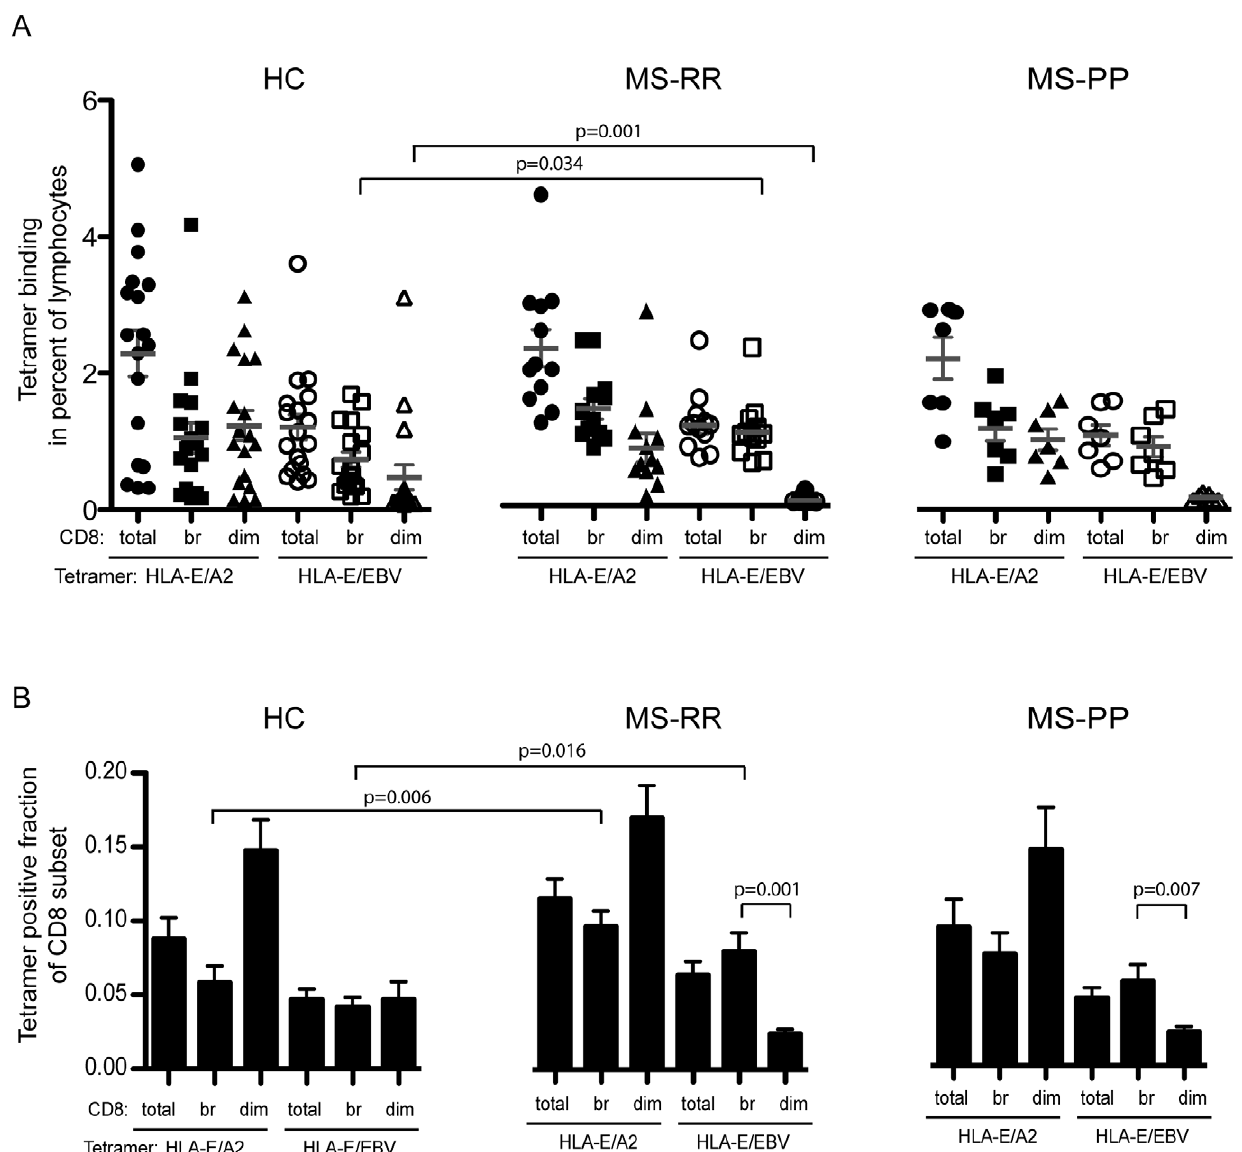
Figure 3. Increased frequency of cells recognizing HLA-E/BZLF1 by CD8 bright cells in MS-RR patients. (A) Mononuclear cells from HC, MS- RR, and MS-PP were incubated with tetramers of HLA-E/A2 and HLA-E/BZLF1 and anti-CD8 antibody. Tetramer positive cells are expressed as percentage of cells binding the tetramer within the lymphogate for CD8 total, CD8 bright , and CD8 dim cells. Mean 6 SEM is indicated (B) The frequency of tetramer positive cells are expressed as a fraction of the indicated CD8 subset to correct for altered number of CD8 + cells between the groups. SEM is indicated on the top of the bars. Comparisons are done using Mann-Whitney U-test. may indicate that the frequencies of tetramer binding cells are